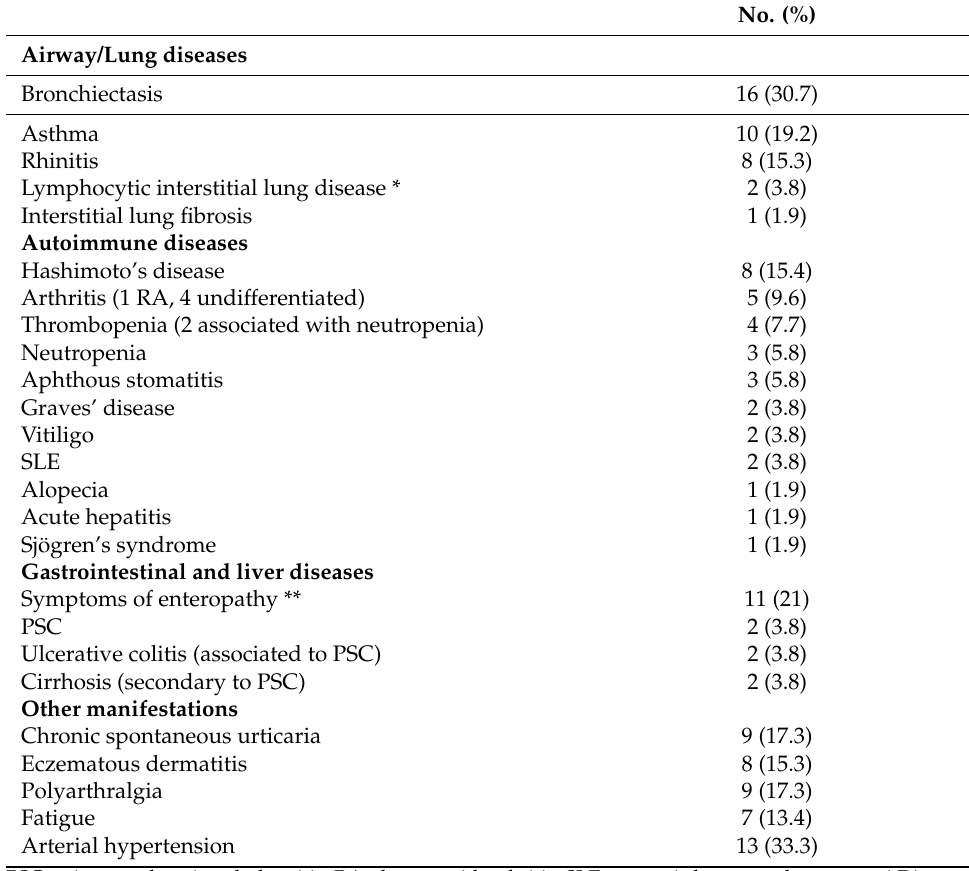
Table 1. Non-infectious